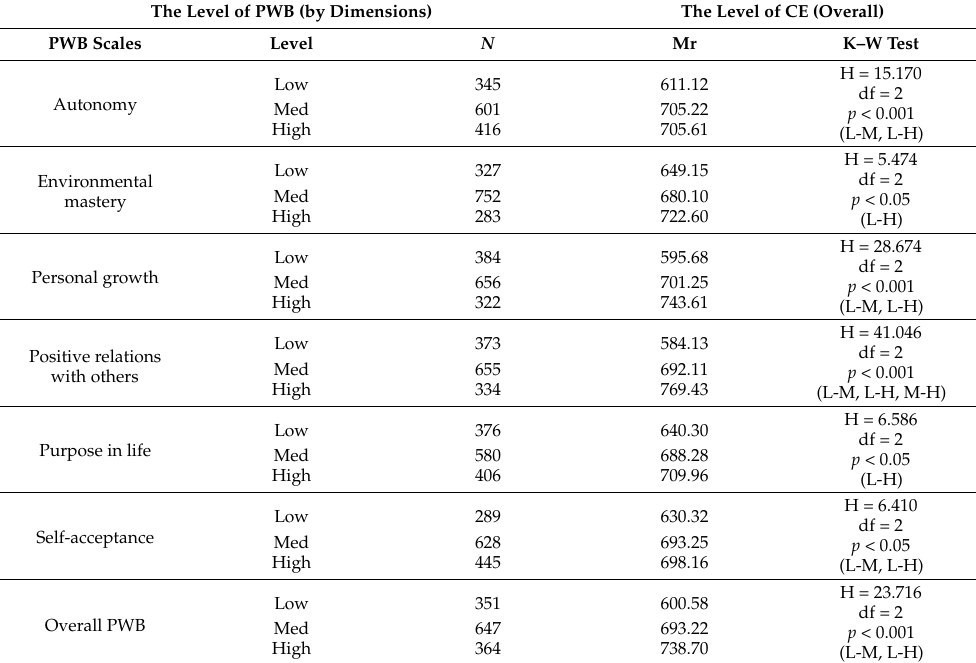
Table 3. Dependent results of the study—students’ psychological well-being during the COVID- 19 outbreak in the experiences of Polish, Croatian, and Lithuanian students versus their civic engagement—results of the Kruskal–Wallis test (one-way ANOVA on ranks); Here, Mr = mean rank, K–W test = Kruskal–Wallis H test, CE = civic engagement, and L-M, L-H, M-H = results of post hoc analysis with Bonferroni tests—mentioned differences in CE mean ranks between the detailed levels of PWB (L-M = low level of PWB vs. medium PWB level; L-H = low vs. high, M-H medium vs. high) are statistically significant (all p < 0.05); (n =